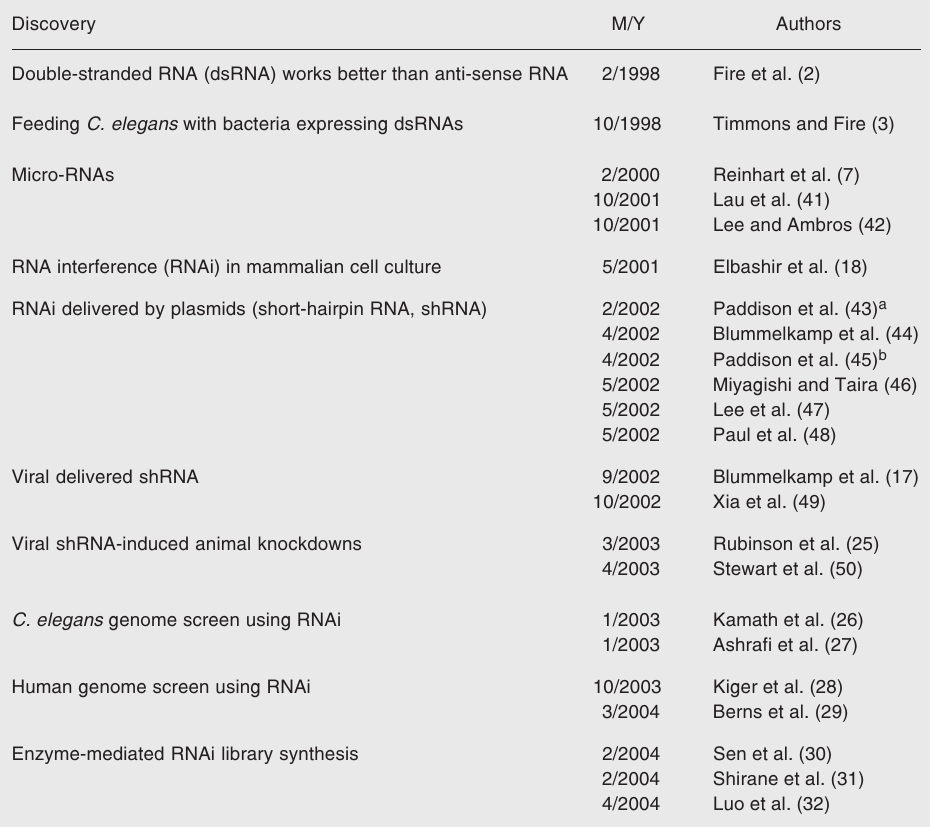
Table 3. A short history of RNAi.